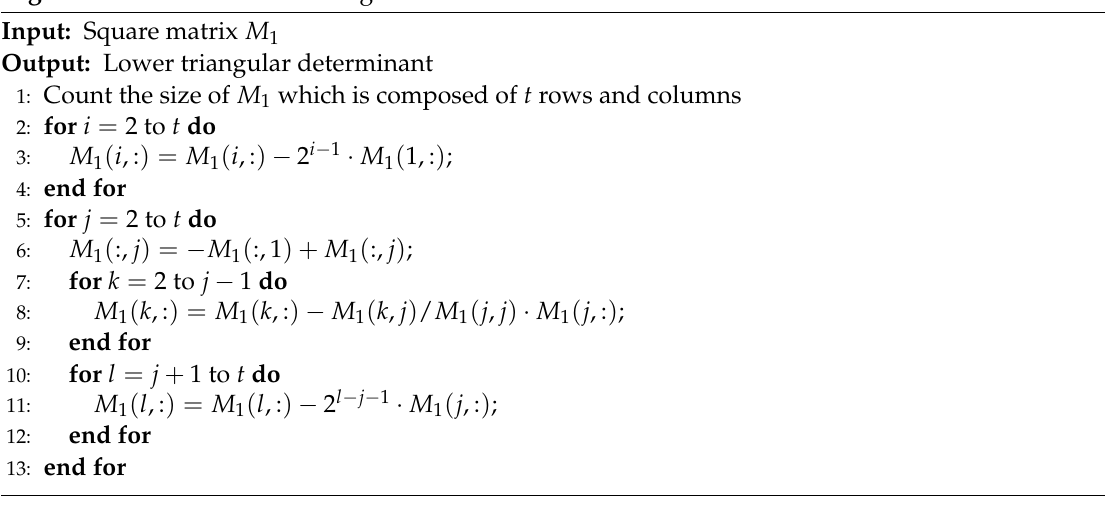
Algorithm 1 Matrix transform